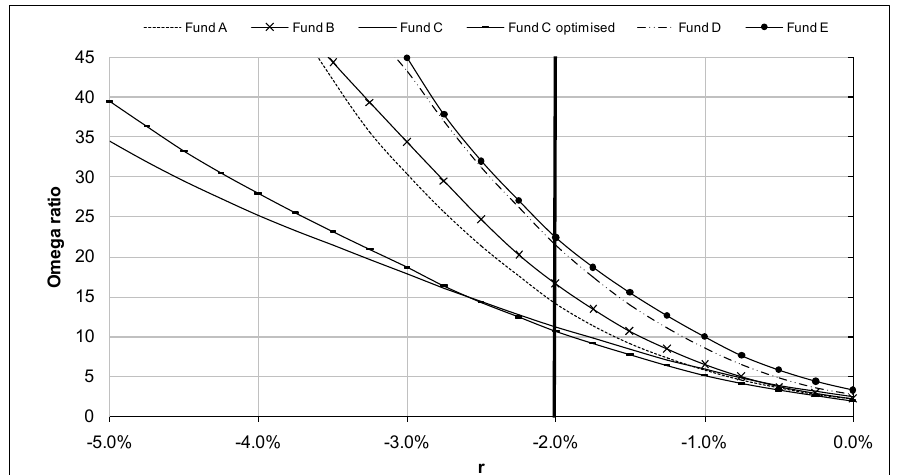
FIGURE 5: Fund C’s optimised Omega results at -2%